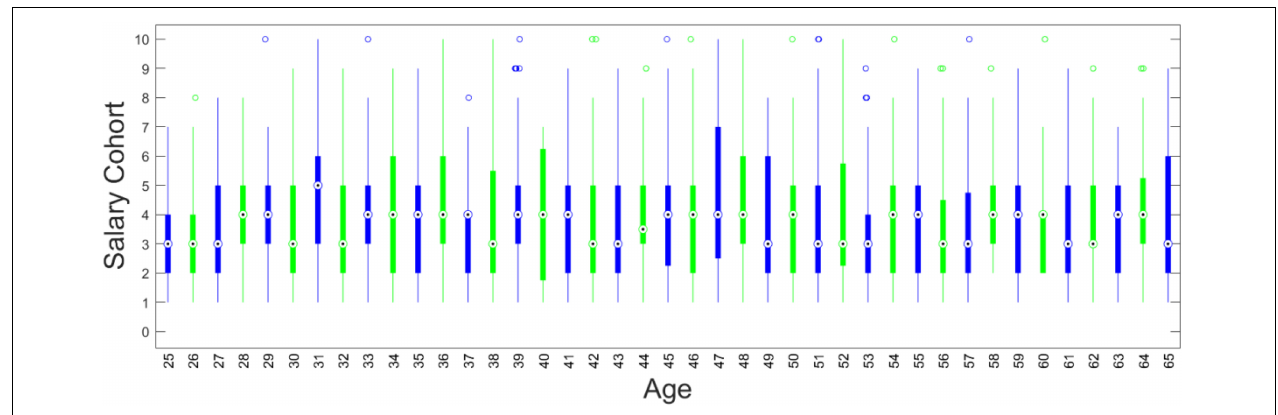
FIGURE 2 | Distribution of salary by age. Each bulls-eye indicates the median value. Higher values indicate higher salaries.